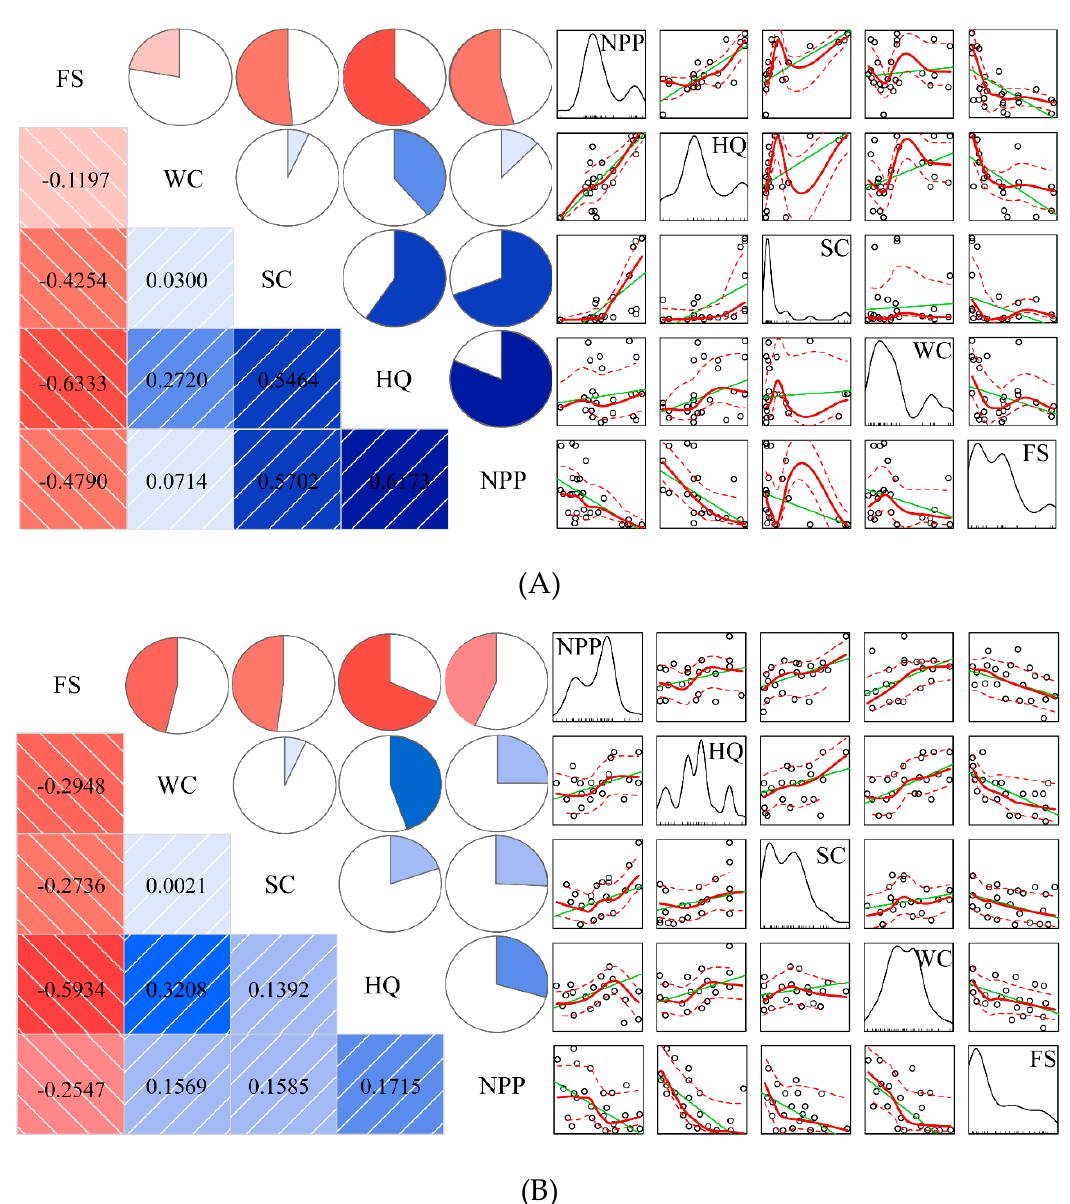
Figure 3. The relationships between average ecosystem services in the Guanzhong Basin ( A ) and in the Hanzhong Basin ( B ) from 2000 to 2018. Based on the R software, pie chart, and scatter plot can directly indicate the relationships between ecosystem services. For example, in the pie chart, the blue color represented positive values, the red color represented negative values, and the intensity of the color increased uniformly as the correlation value increased. The shading of the lower triangular in the figure had the same meanings in color as the circles of the upper triangular. Furthermore, the intensity of color scaled in proportion to the magnitude of correlation values, besides the circles were filled clockwise for positive values and anti-clockwise for negative values. In the scatter plot, all data may be considerably enhanced by the addition of linear regression lines, (loess) smoothed curves, and so forth. The key diagonal represented the kernel density curve and the lower horizontal axis was the shaft figure. Other figures contained linear and smooth fitting curves.